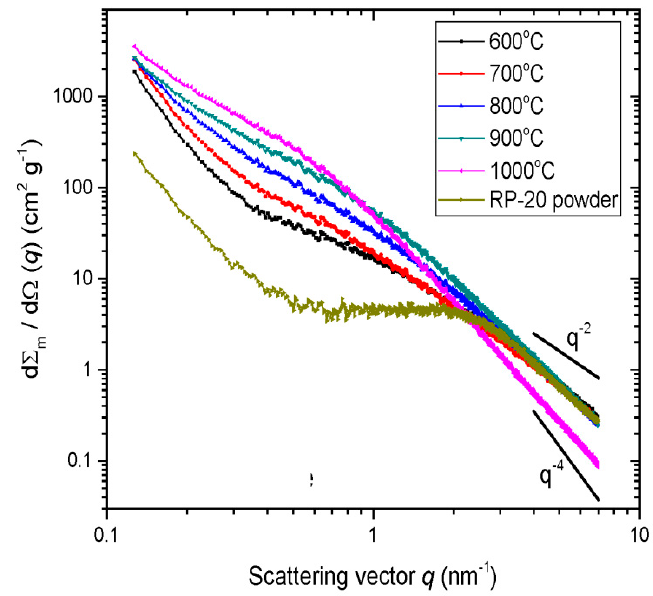
Figure 1. Analysis of carbide-derived carbons (CDC) by small-angle X-ray scattering: Mass normalized scattering curves of CDC powders [25] synthesized at different temperatures compared with commercial RP-20 carbon powder [74,85], as noted in the Figure. Reproduced with permission from [74,75] copyright© 2019, Elsevier.